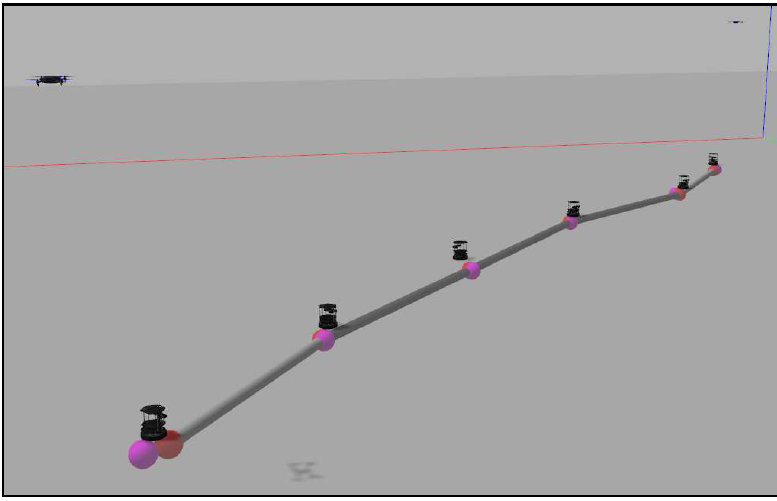
Figure 17. Final layout in an experiment with two targets separating into opposite